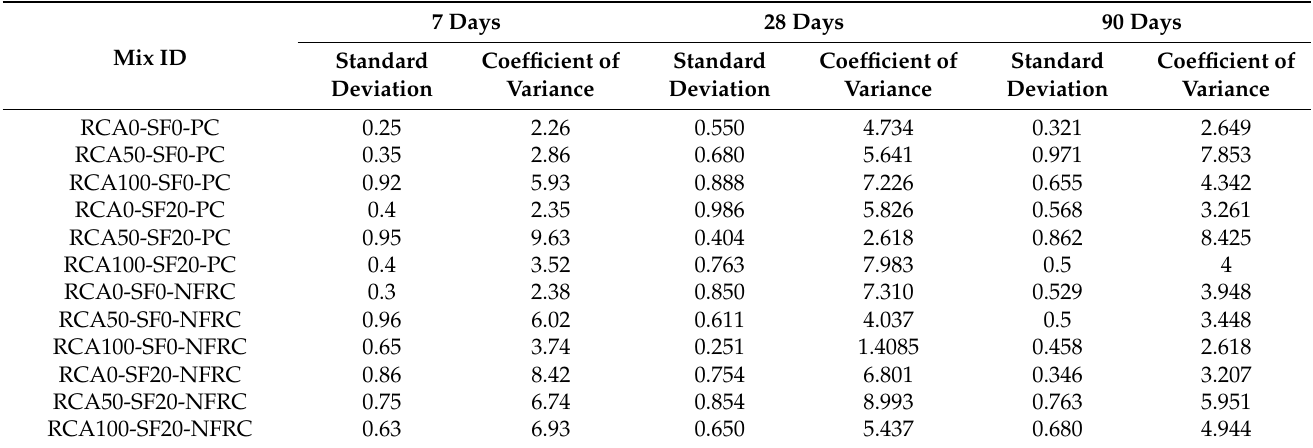
Table 6. Standard Deviation and Coefficient of Variation for Compressive Strength